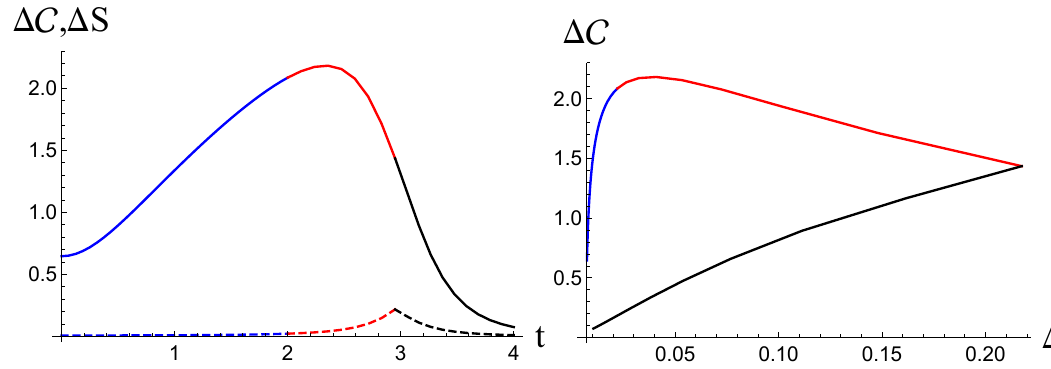
Figure 4 . On the left plot we present the time dependence of the (rescaled) complexity (solid curve) and the (rescaled) entanglement entropy (dashed curve) of x 2 ( (cid:0) 3 ; 3) interval for the same parameters. The right one is a parametric plot where we show the complexity (cid:1) C of the quenched subsystem as a function of (evolving in time) entropy. The red, the blue and the black curves here correspond to the same time intervals as on the left